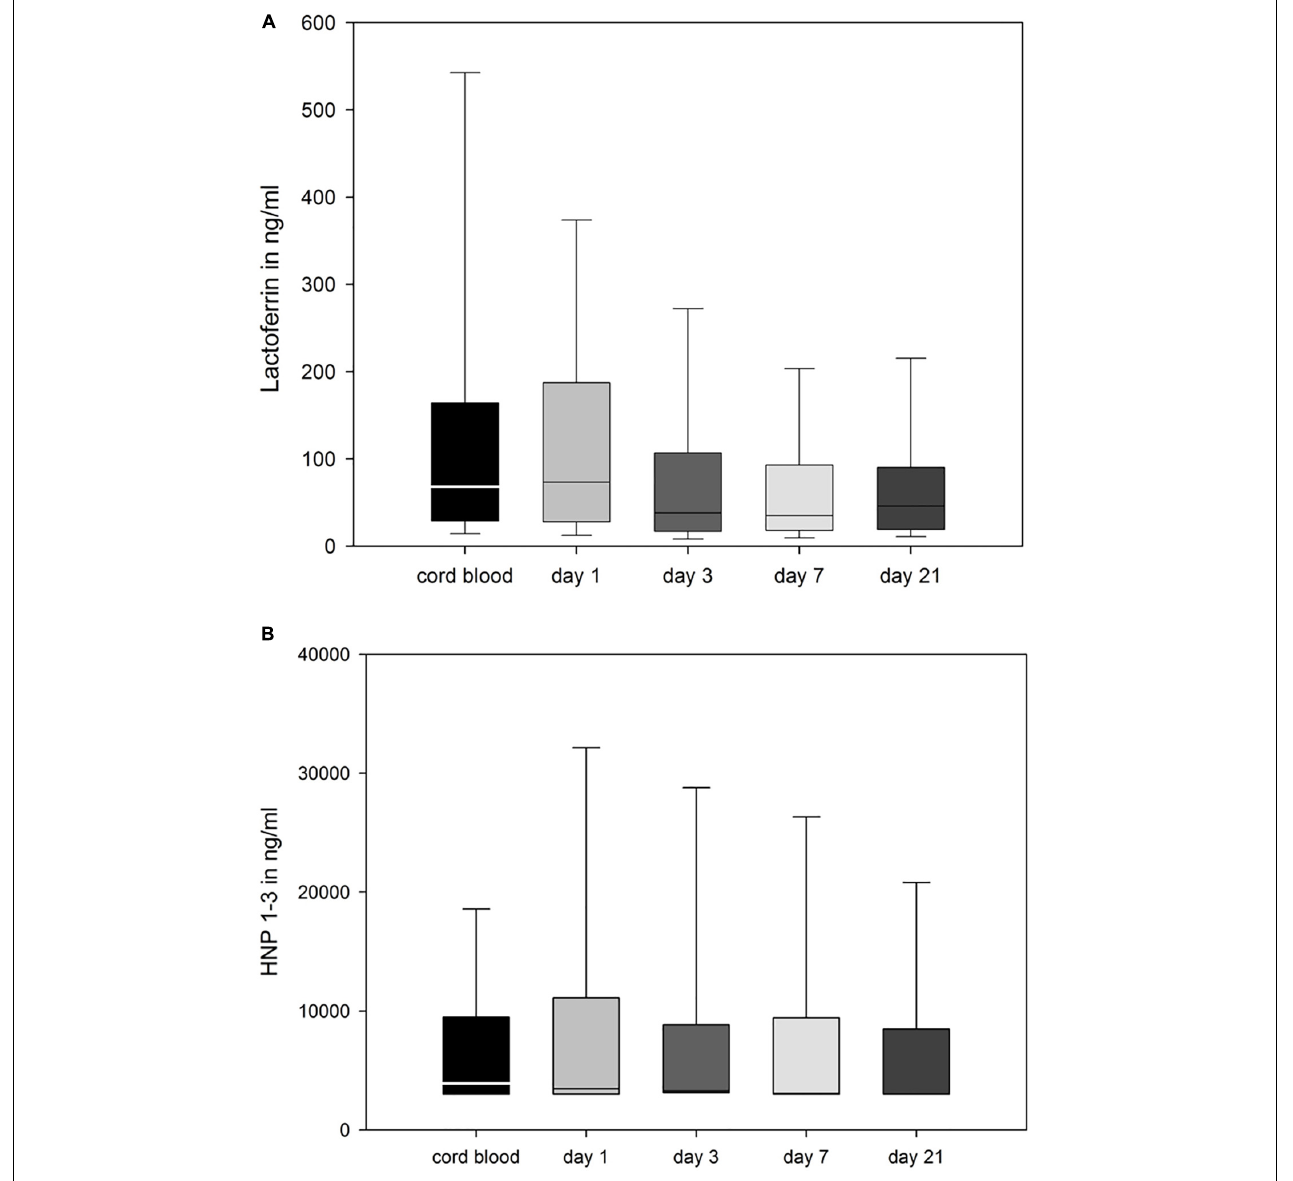
FIGURE 3 | LF (A) , and HNP 1–3 (B) in ng/ml in cord blood and peripheral blood of the infant taken at days 1, 3, 7, and 21. Data is represented as box plot (median, 25th/75th, and 10th/90th